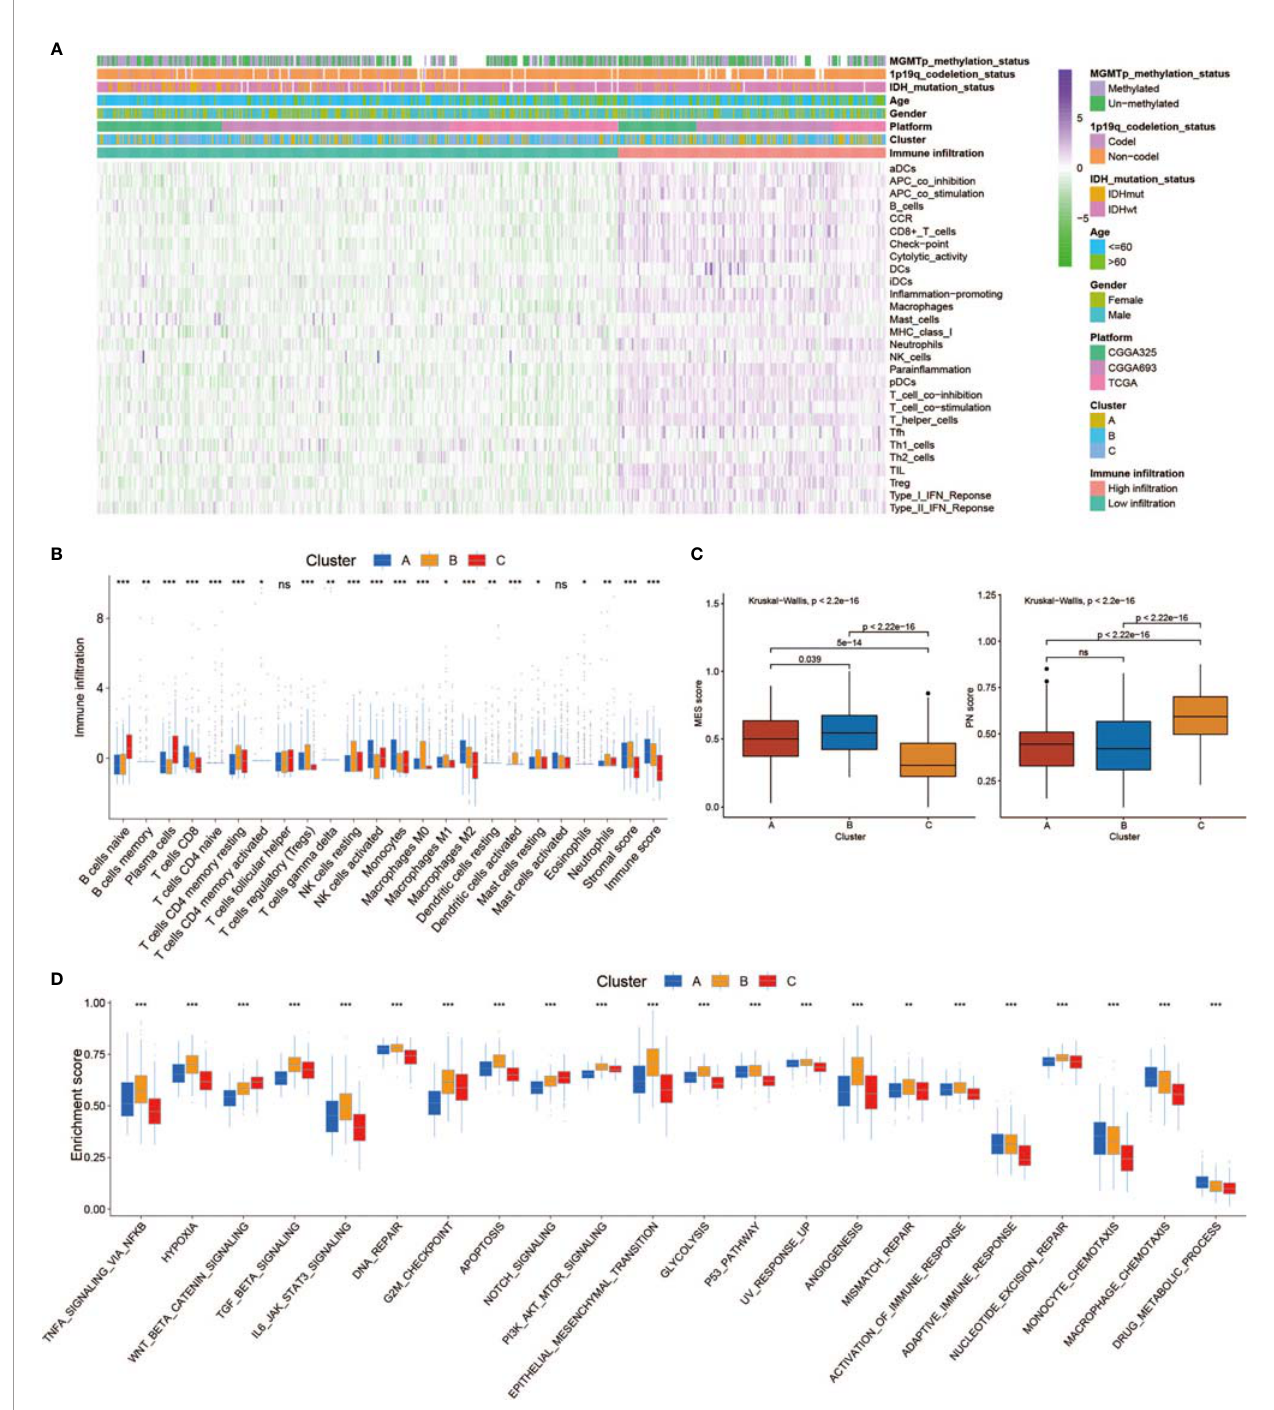
FIGURE 3 | Tumor microenvironment (TME), subtypes, and clinical information in three non-m 6 A RNA modi fi cation clusters. (A) Unsupervised clustering of GBMs using ssGSEA scores from 28 immune-related gene sets. Two signi fi cant immune in fi ltration patterns are presented. The non-m 6 A RNA modi fi cation patterns and other clinical characteristics were used as patient annotations. (B) The abundance of tumor-in fi ltrating immune cells, stromal scores, and immune scores in three non-m 6 A RNA modi fi cation patterns. (C) Differences in mesenchymal/proneural (MES/PN) scores quanti fi ed by ssGSEA among the three non-m 6 A RNA modi fi cation patterns. (D) Differences in the TME in fi ltration and MES transition pathways among three non-m 6 A RNA modi fi cation patterns. * means P<0.05; ** means P<0.01; *** means P<0.001; ns means